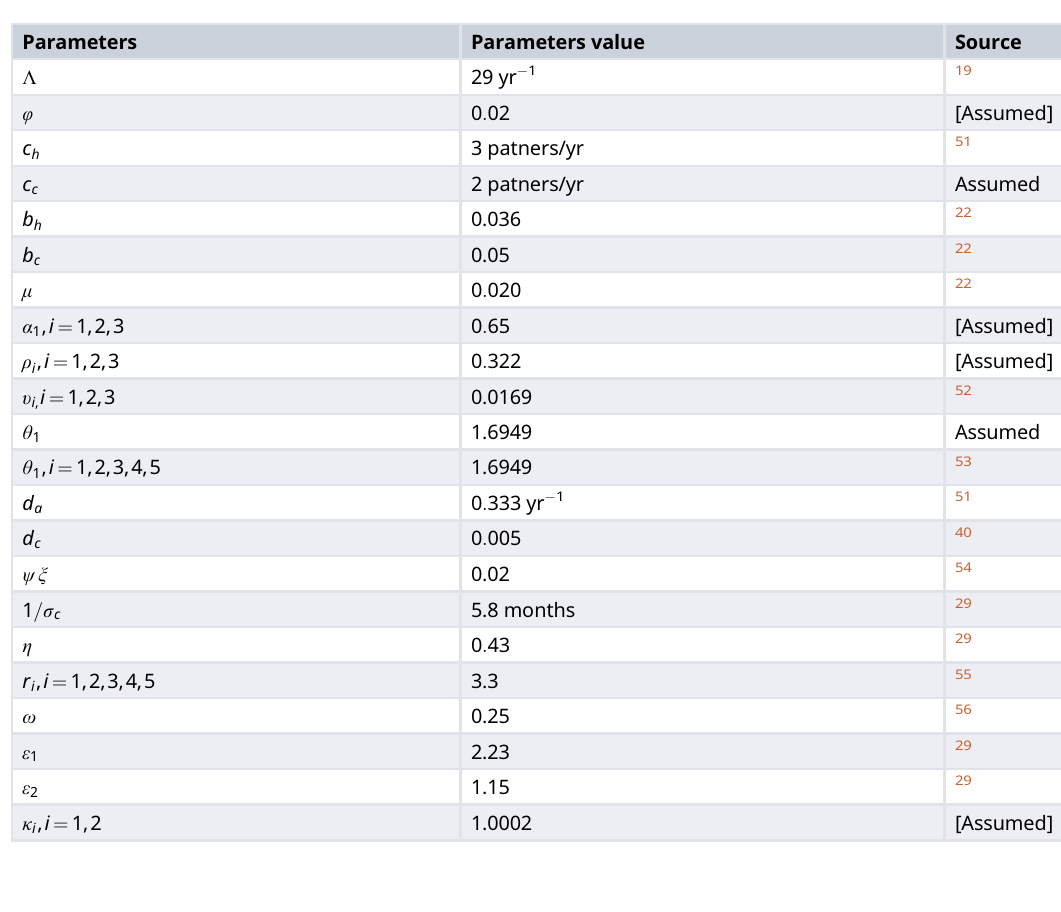
Table 2. Parameters used in the numerical simulations of model.